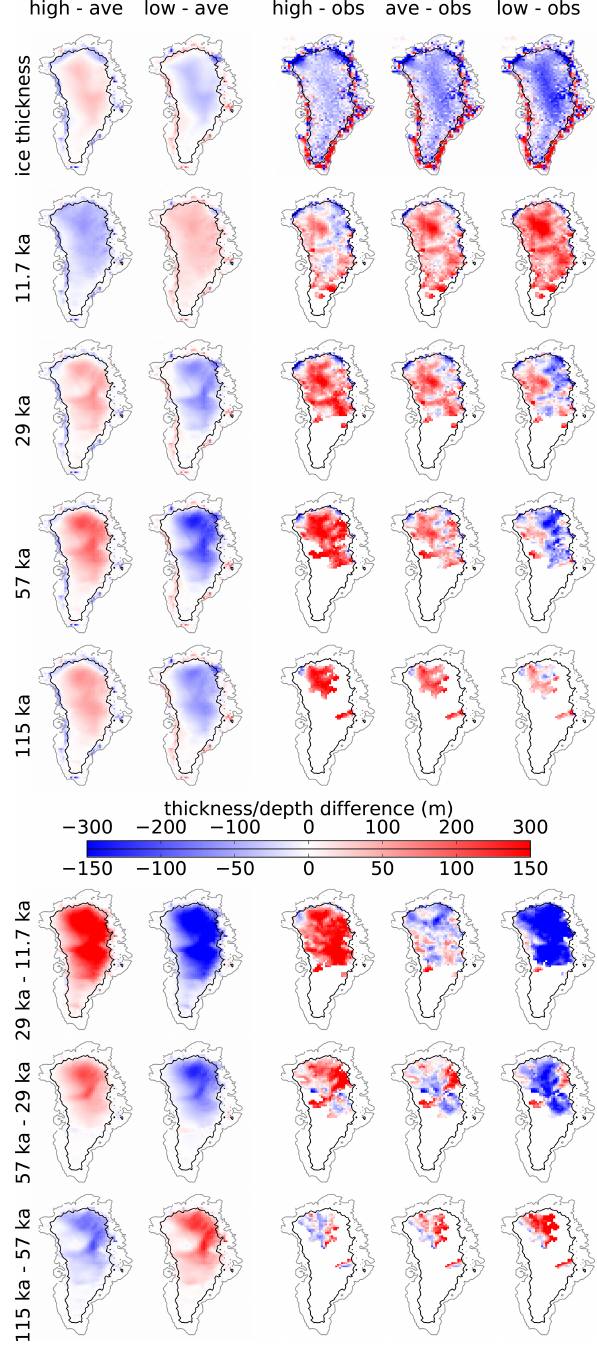
Figure A2. Like Fig. A1, but for composites of variable f LGM . The ranges of the high and low composites are 1.5 to 2 and − 2 to −